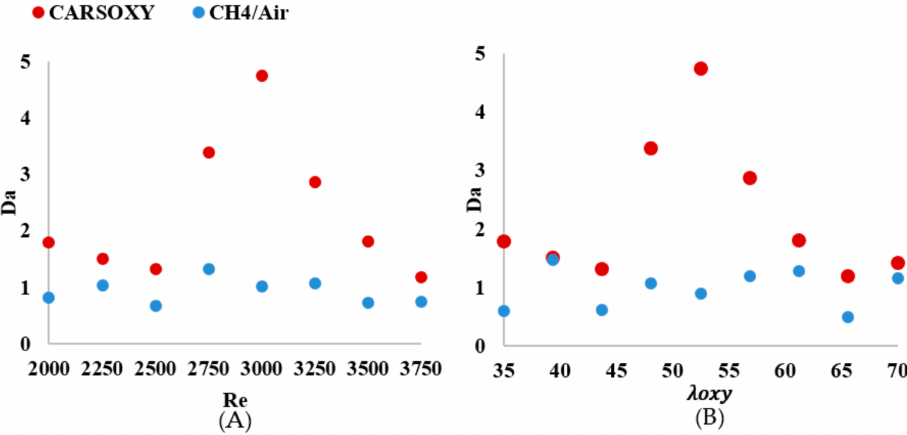
. V CH4 = 1 L/min and